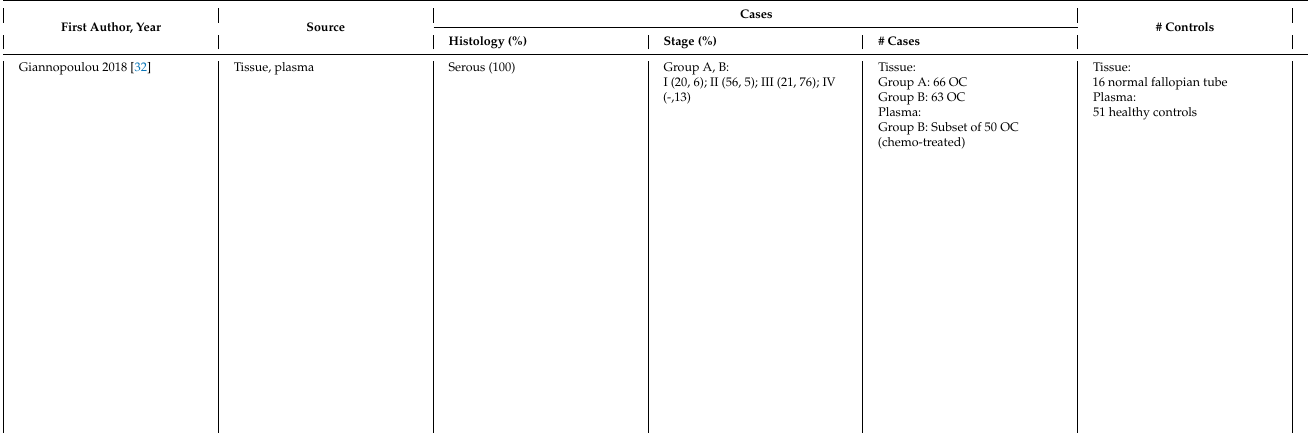
survival ———————– Extrapolatedsummaryfor plasmatestindifferentiatingOC fromhealthycontrols: